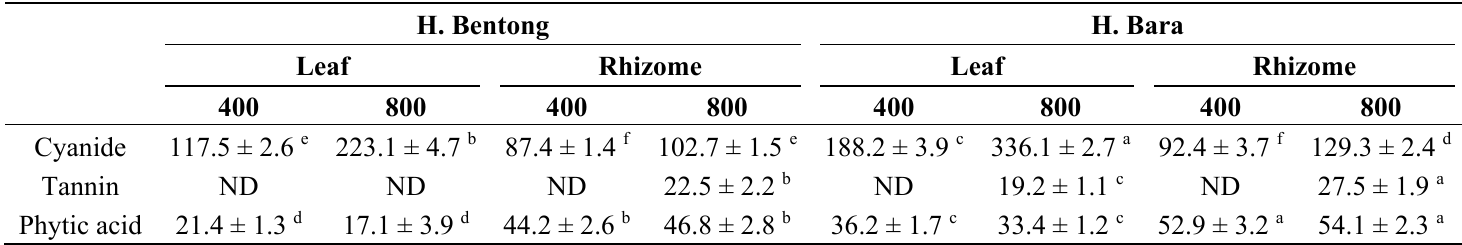
Table 4. Antinutrient contents in the leaf and rhizome of two ginger varieties grown under different CO 2 concentration (400 and 800 μ